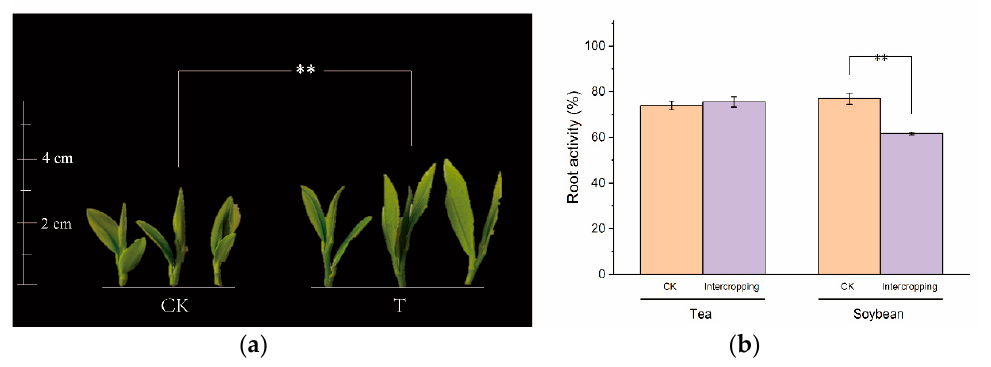
Figure 1. Effect of tea plant/soybean intercropping on ( a ) growth performance and ( b ) root activity. CK: tea plant in monoculture. T: tea plant in tea plant/soybean intercropping system. All data are shown as the mean ± SD ( n = 3). Asterisks represent significant differences (Tukey’s HSD test, p < 0.05).